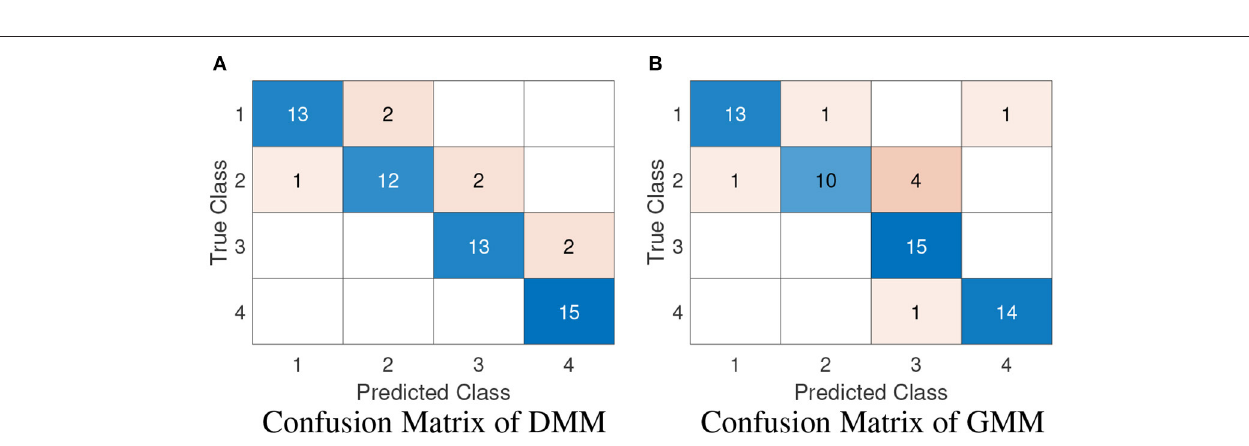
FIGURE 13 | Confusion matrices in 60 testing trials (15 trials for each path). (A) The confusion matrix of the Dirichlet mixture model. (B) The confusion matrix of the Gaussian mixture model.